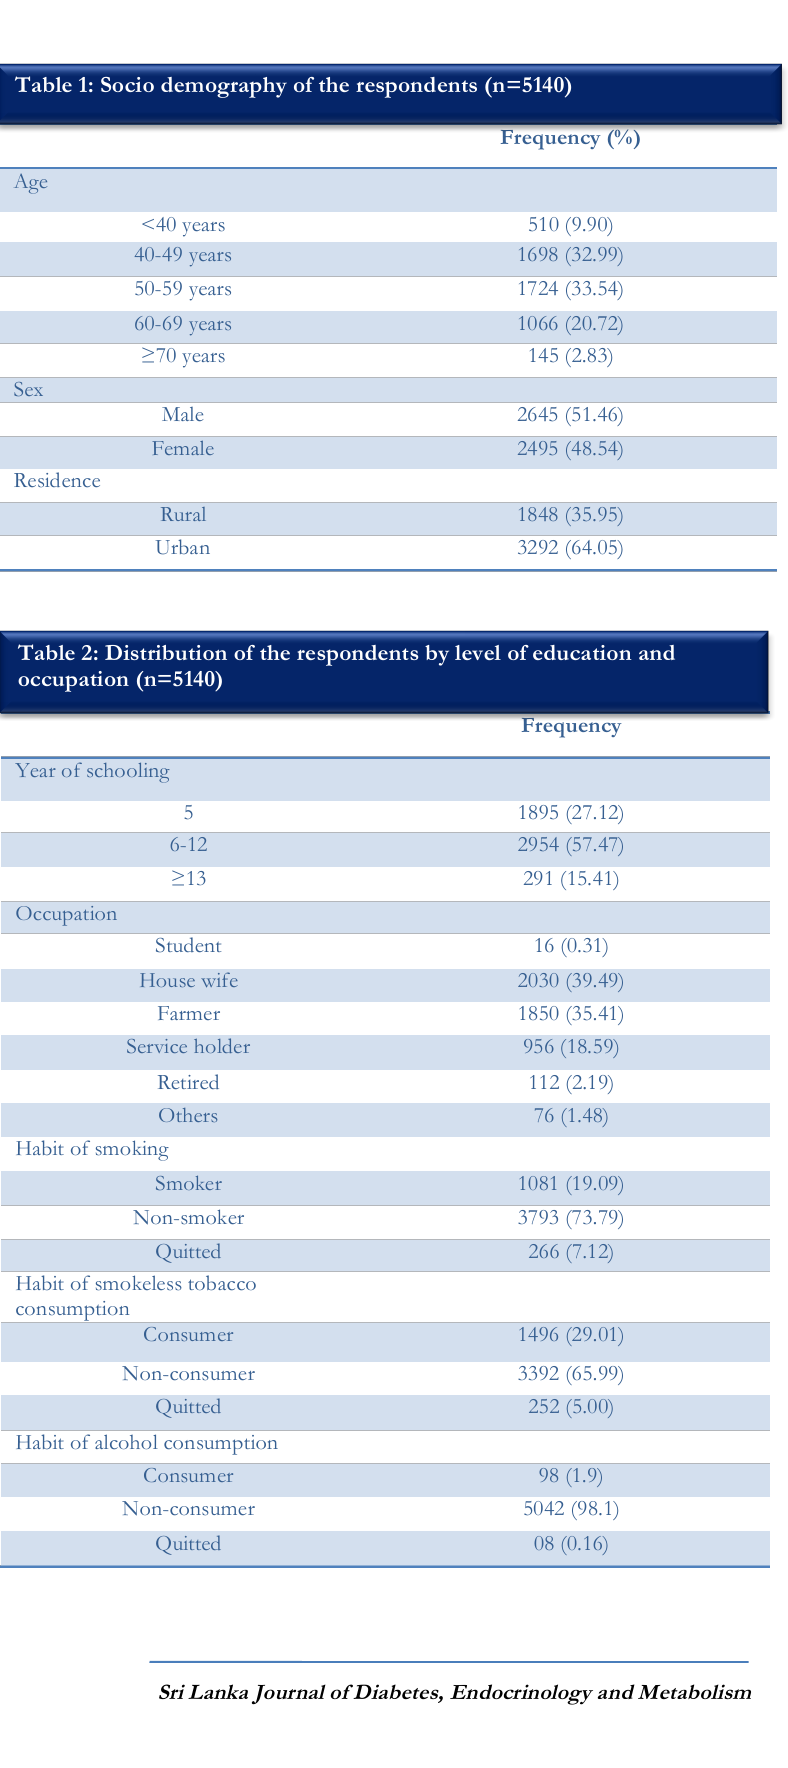
about co-morbid illnesses was used.